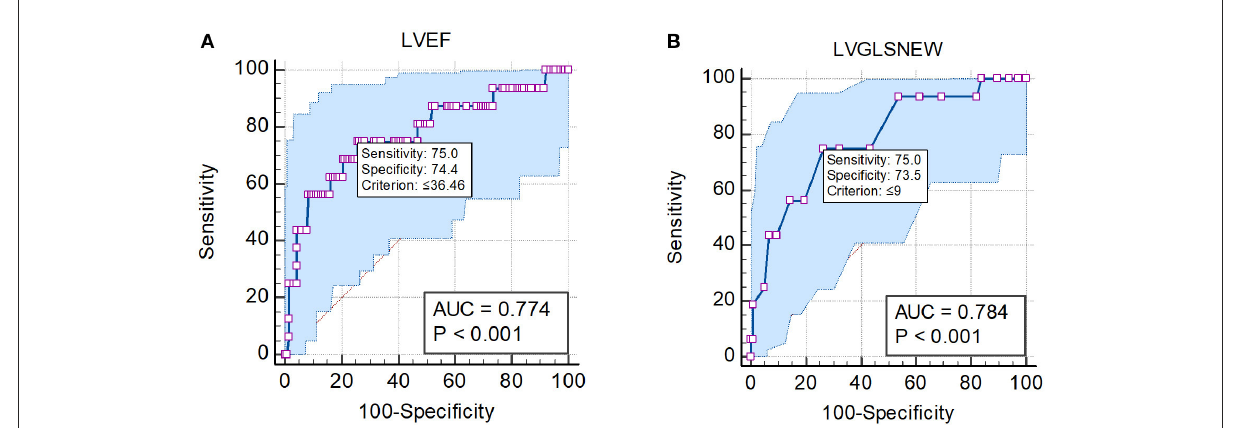
FIGURE3 ROC analysis results for (A) LVEF. (B) LVGLS in patients with acute